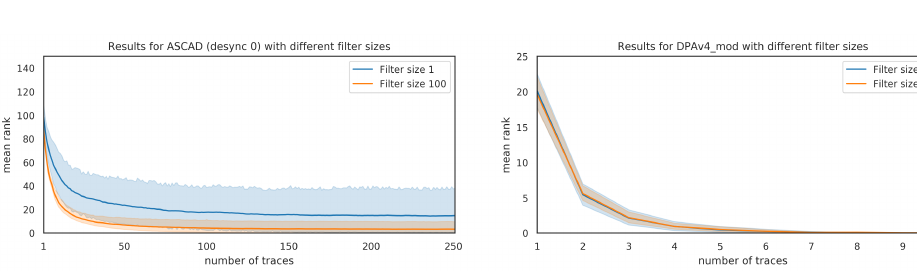
Figure 5: Guessing entropy comparing different filter sizes (1 and 100) on the same model used for the DPAv4_mod